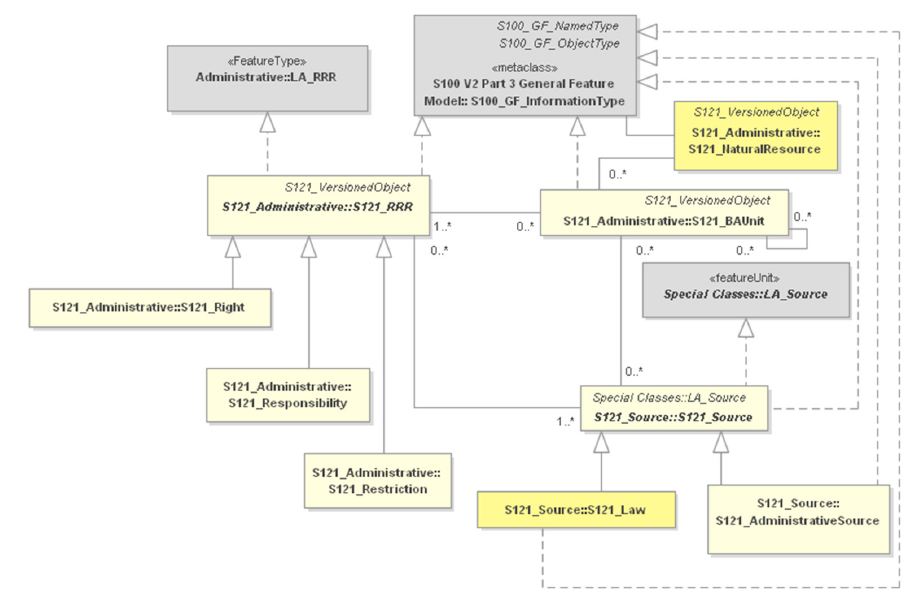
Figure 6. S-121 Administrative package ([18], p. 59, edited).